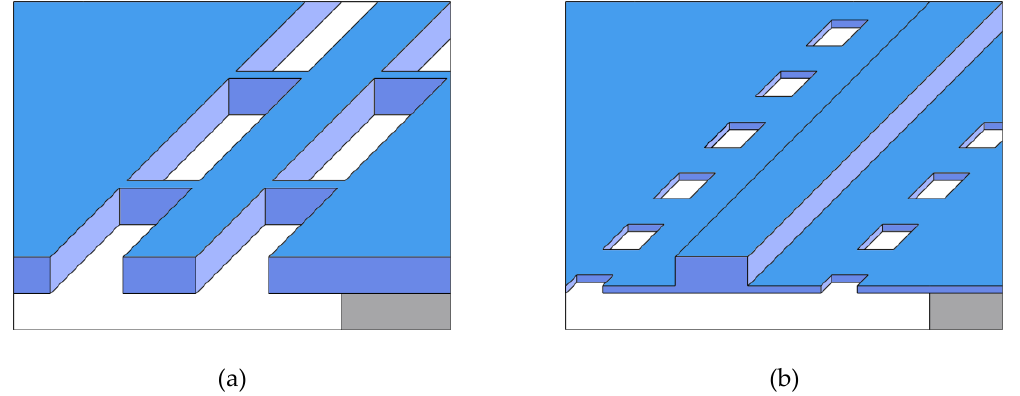
Figure 1. Suspended waveguide schemes: ( a ) nanowire anchored by tethers; ( b ) nanorib bounded by etch windows. Tethers and windows have no impact on optical propagation.